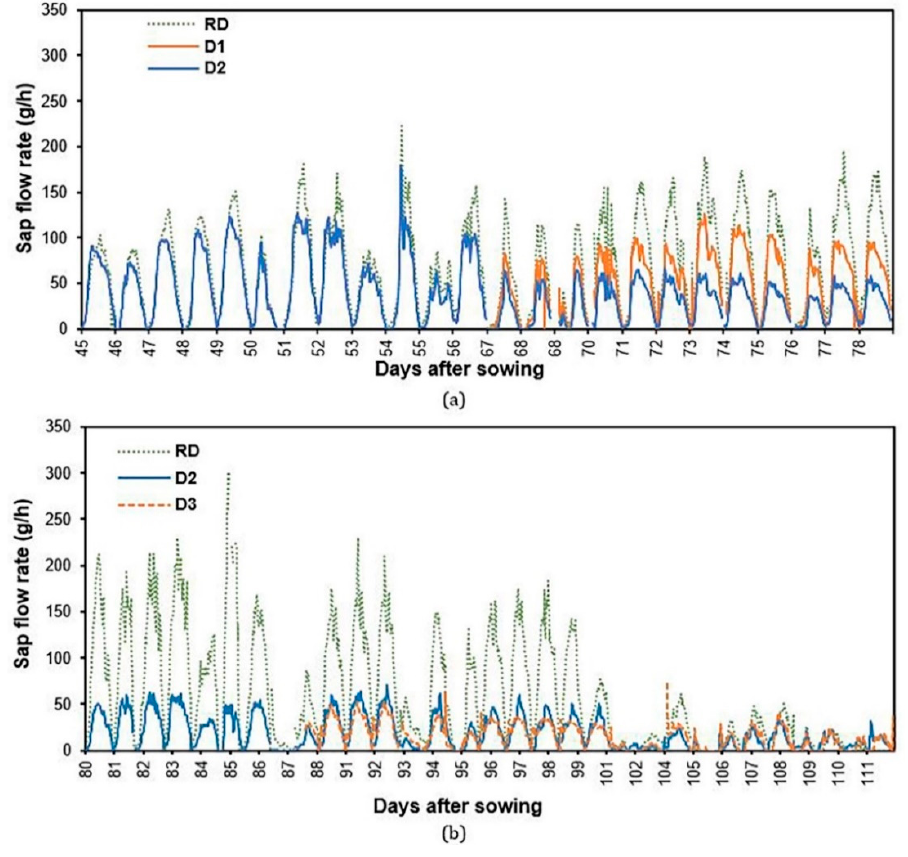
Figure 5. Variations of maize sap flow rates under different drought stress. ( a ) Period: between the 45th and 79th day, and ( b ) between the 80th and 110th day.